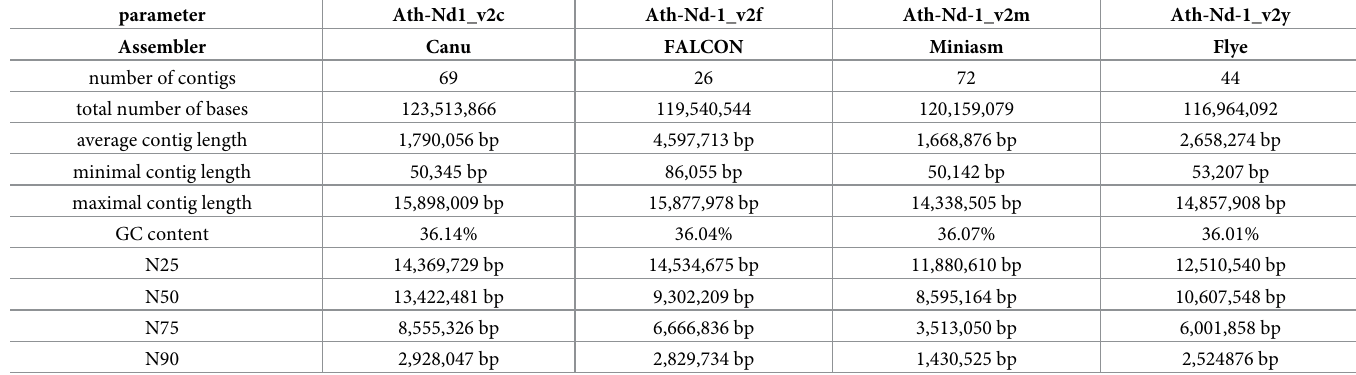
Table 1. Nd-1 de novo assembly statistics. Metrics of assemblies of the Nd-1 nucleome sequence generated by Canu, FALCON, miniasm, and Flye. All described assem- blies are the final version after